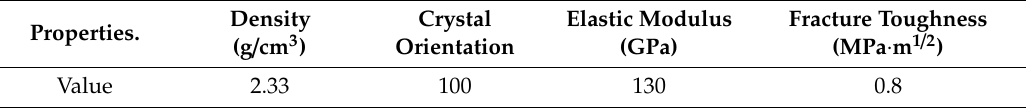
Figure 5. The schematic of ultrasonic assisted sawing experiment. ( a ) Ultrasonic vibration generator system; ( b ) Signal acquisition system. Table 1. Monocrystalline silicon